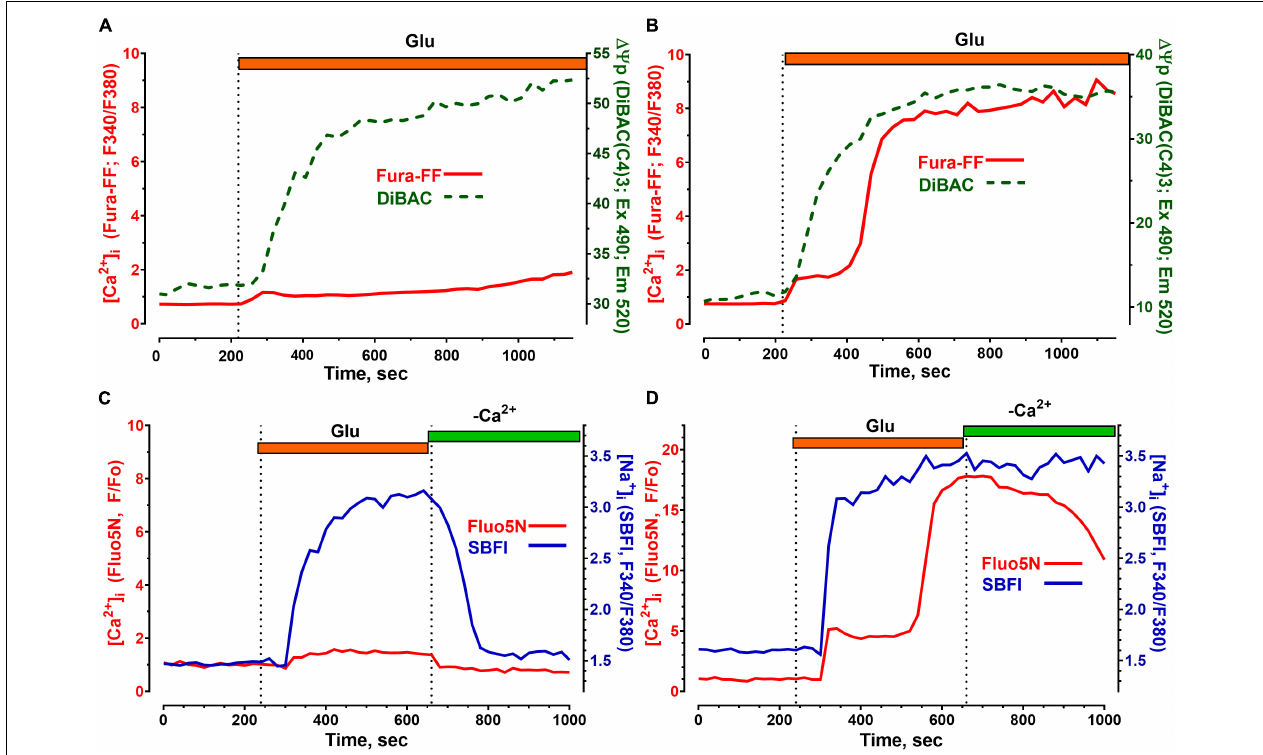
FIGURE 4 | Changes in the concentration of free intracellular Ca 2 + ([Ca 2 + ] i ), Na + ([Na + ] i ) and in the plasmalemmal transmembrane potential ( (cid:49)(cid:57) p) induced by toxic doses of glutamate in cerebellar neurons. [Ca 2 + ] i measurements were performed using low-affinity fluorescent Ca 2 + indicators Fura-FF (A,B) and Fluo-5N (C,D) and are given in relative units (F340/F380, Fura-FF) and (F/Fo, Fluo -5N). The fluorescent Na + indicator SBFI was used to measure [Na + ] i (C,D) . Changes in [Na + ] i are given in relative units (F340/F380). Changes in (cid:49)(cid:57) p (A,B) were monitored using a DiBAC (C4)3 fluorescent probe; a decrease in (cid:49)(cid:57) p causes the accumulation of the probe in the cytoplasm and therefore corresponds to an increase in the DiBAC (C4)3 signal. Voltage-sensitive probe DiBAC (C4)3 was excited with 485 nm and its fluorescence was registered at 525 nm. Glu concentration and buffers were the same as in Figure 1 .